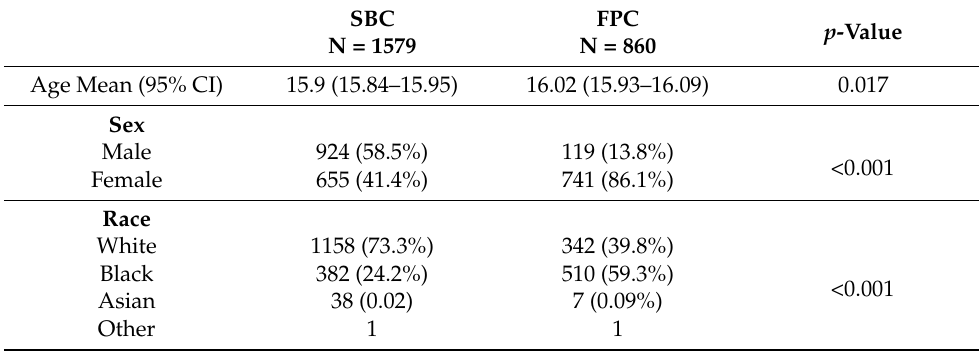
Table 1. Demographic characteristics of 2439 unique adolescents seen at school-based (SBC) and family planning clinics